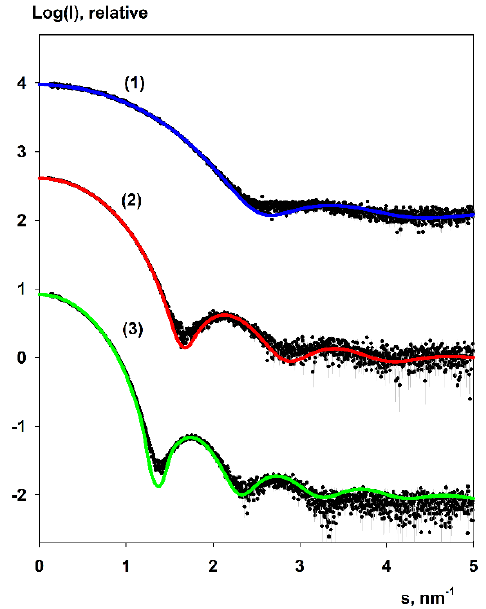
Figure 6. Small angle X-ray scattering (SAXS) patterns of the 4th (1), 6th (2), and 7th (3) generations of carbosilane-siloxane dendrimers. The experimental data are shown as dots with error bars, scattering from the MD models as solid lines. Table 3. Overall structural parameters obtained by SAXS.